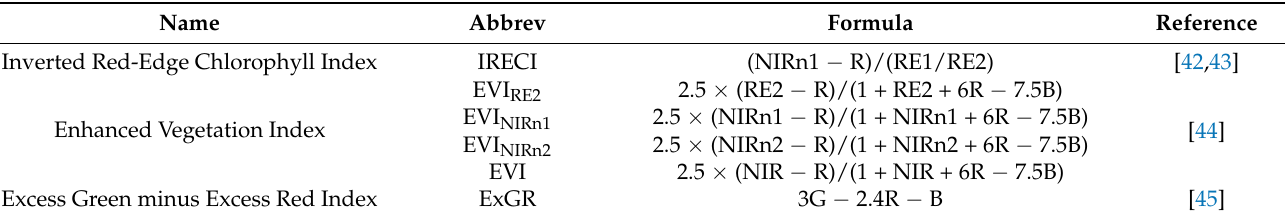
Table 2. Vegetation indices used in this